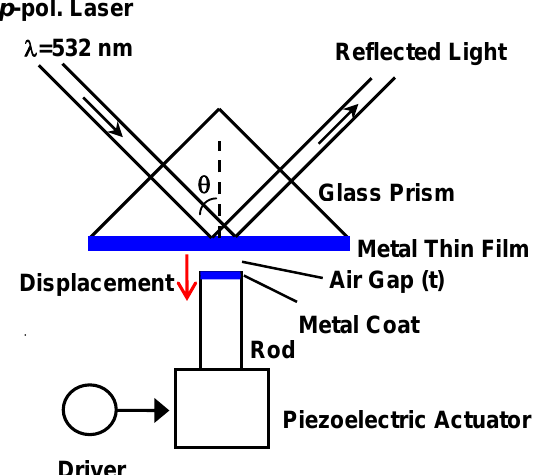
Figure 2. The p -polarized light beam of 1-mm diameter was incident to a 45°–right-angle prism of BK-7 glass ( n = 1.5195 at  = 532 nm) with a thin silver (Ag) film at the ATR-mode excitation angles of 43–45°. The Ag thin film was fabricated on a microscope-cover glass substrate of BK-7 using vacuum evaporation at a thickness of 55 nm; the substrate was fixed on the flat base of the prism with the appropriate immersion oil. Figure 2. Schematic of the experimental setup for the excitations of enhanced evanescent fields in the microcavity and for successively changing the air-gap distance between two